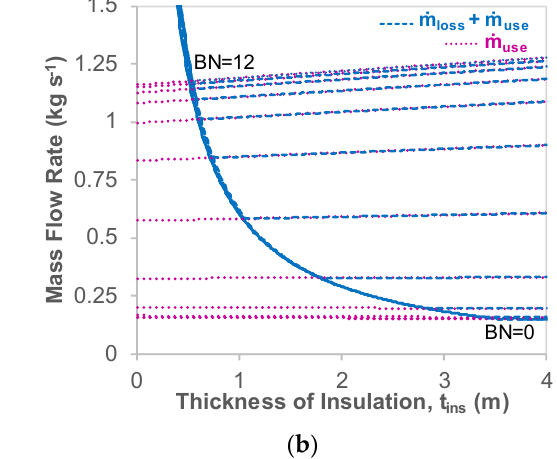
Figure 6. Variation of boil-off ( m ̇ use + m ̇ loss ) and fuel utilisation rate ( m ̇ use ) with insulation thickness, at Beaufort numbers (BN) of 0 to 12 and ship velocities ( v ship ) of 16.9, 16.9, 16.7, 16.4, 15.2, 11.8, 7.06, 3.50, 1.63, 0.779, 0.390, 0.205 and 0.113 knots, respectively. The ship models are: ( a ) an LNG ship; and